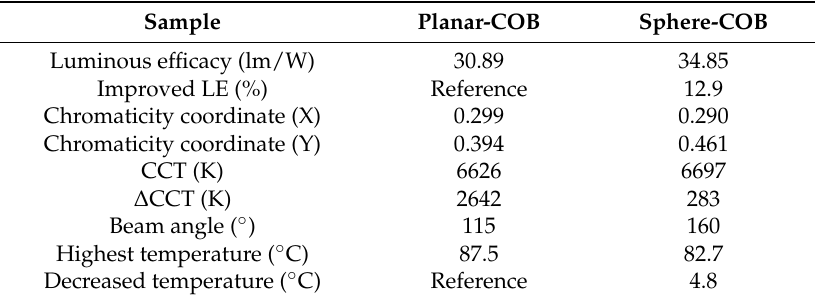
Table 1. Comparison of conventional planar-COB and